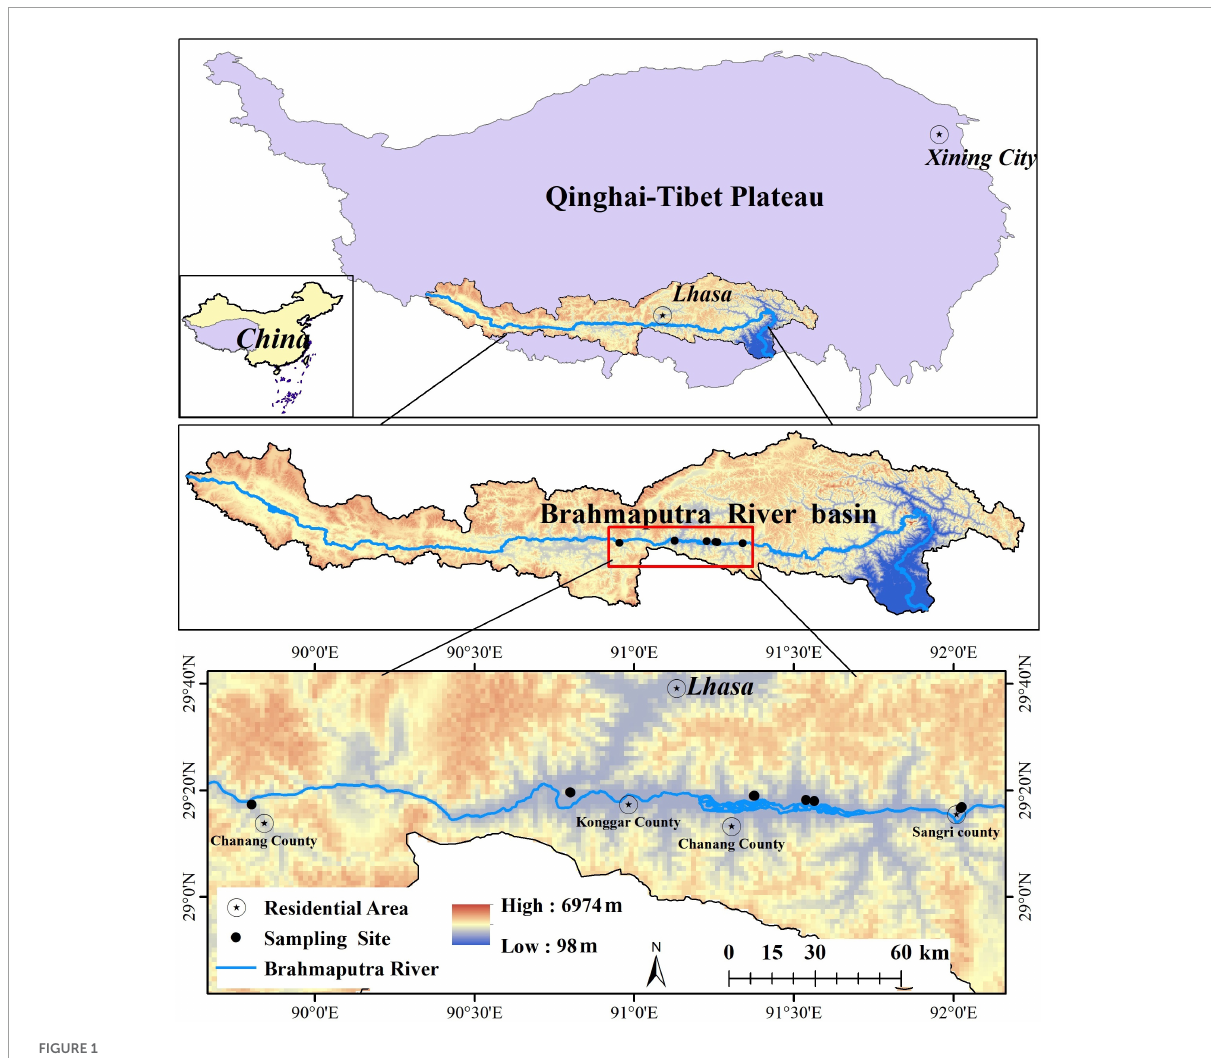
FIGURE1 Location of the study area and distribution of the soil sampling